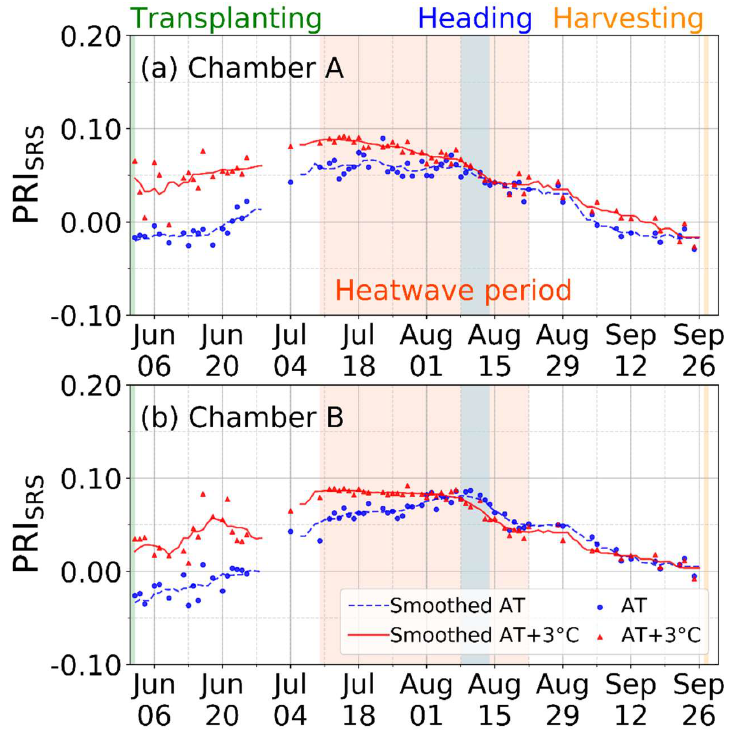
Figure 7. Time series of PRI measured continually by a spectral reflectance sensor (SRS) in different positions for ambient temperature (AT) and AT+3 °C.